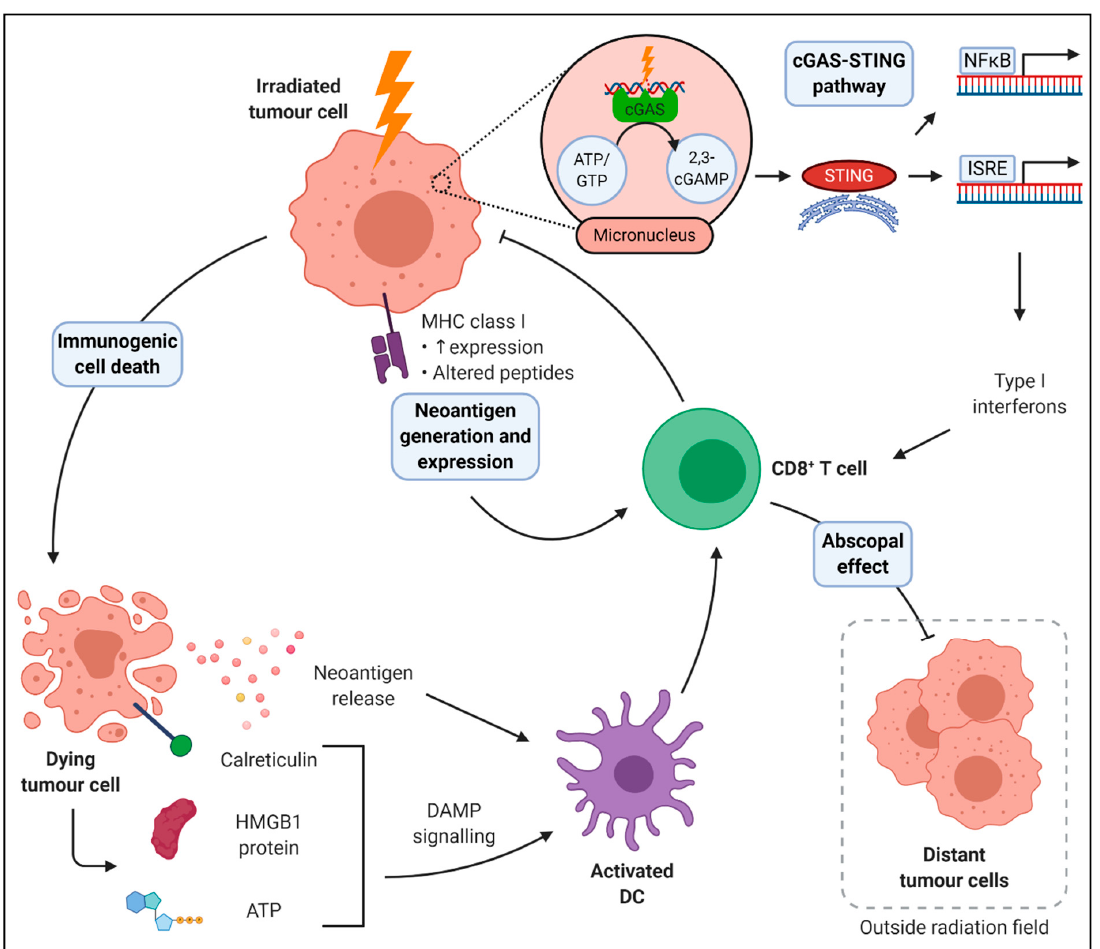
Figure 2. Immunogenic effects of radiation therapy. Radiation can augment anti-tumour immunity in several ways. Damage and death of cancer cells leads to release of tumour neoantigens and damage-associated molecular patterns (DAMPs) such as calreticulin, high motility group box 1 (HMGB1) protein, and ATP which activate dendritic cells (DCs) to prime and stimulate CD8 + T cells responsible for cancer cell detection and elimination. Moreover, radiation can increase the expression and alter the array of peptides presented on major histocompatibility (MHC) class I proteins, which CD8 + T cells use to identify transformed cells. Radiation-induced DNA damage can activate the cGAS-STING pathway leading to type I interferon production which enhances CD8 + T cell activity. Beyond local effects, radiation may induce systemic anti-tumour immunity if tumour-specific CD8 + T cells migrate to metastatic lesions; regression of distant tumour cells outside the radiation field is known as the abscopal